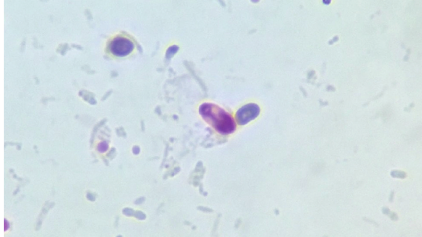
Figure 11: Magnified view of microsporidial spore on modified trichrome stain, under oil immersion.